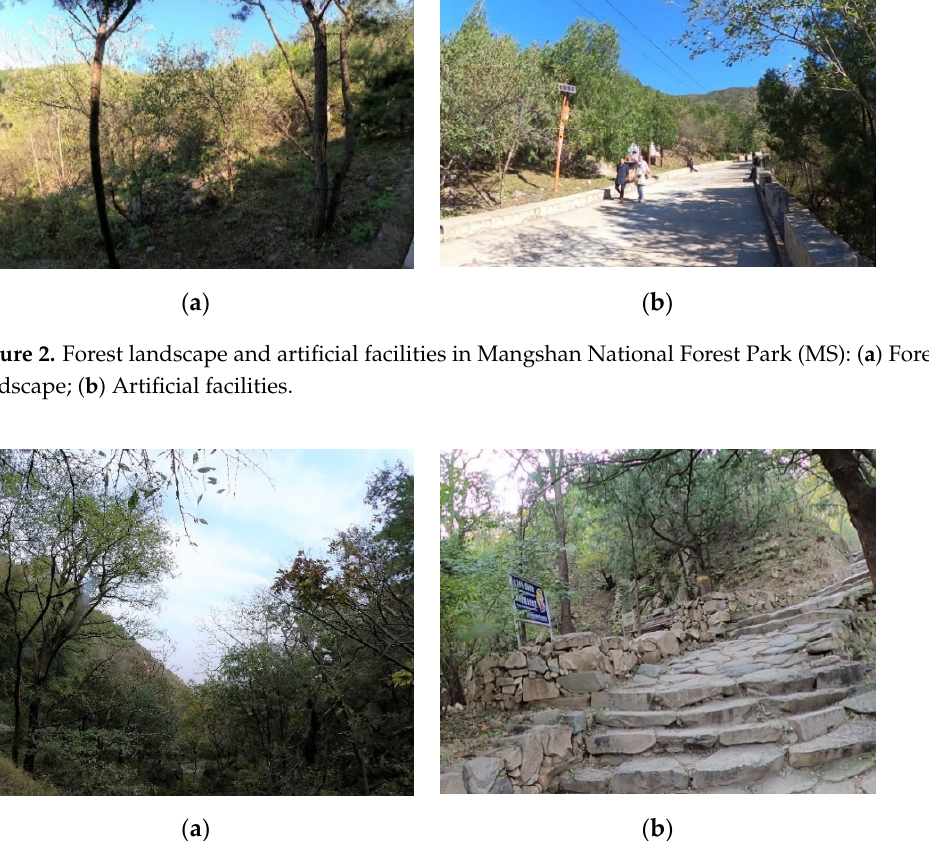
Figure 3. Forest landscape and artificial facilities in Jiufeng National Forest Park (JF): ( a ) Forest land- scape; ( b ) Artificial facilities.